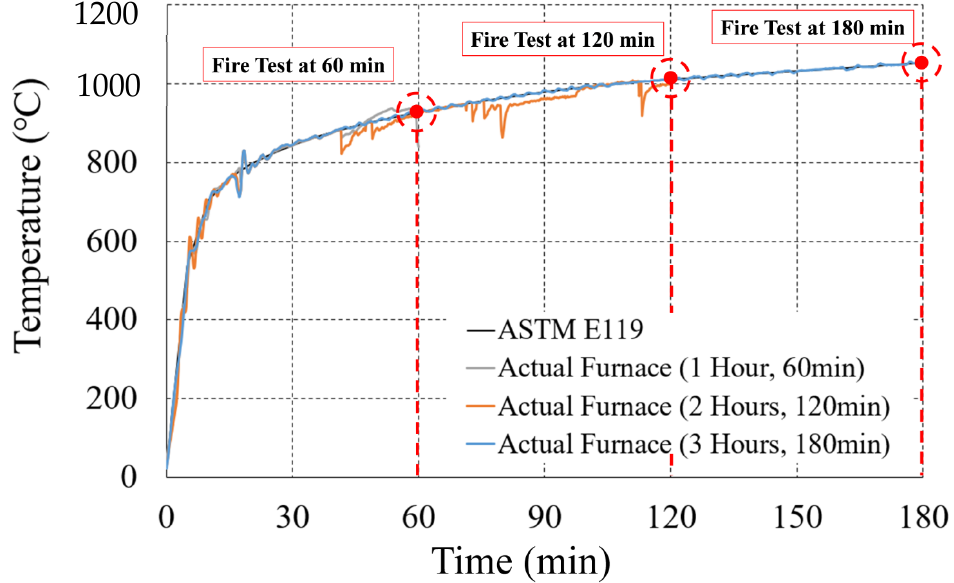
Figure 6. Time-temperature curve (ASTM E119-15 [35]).